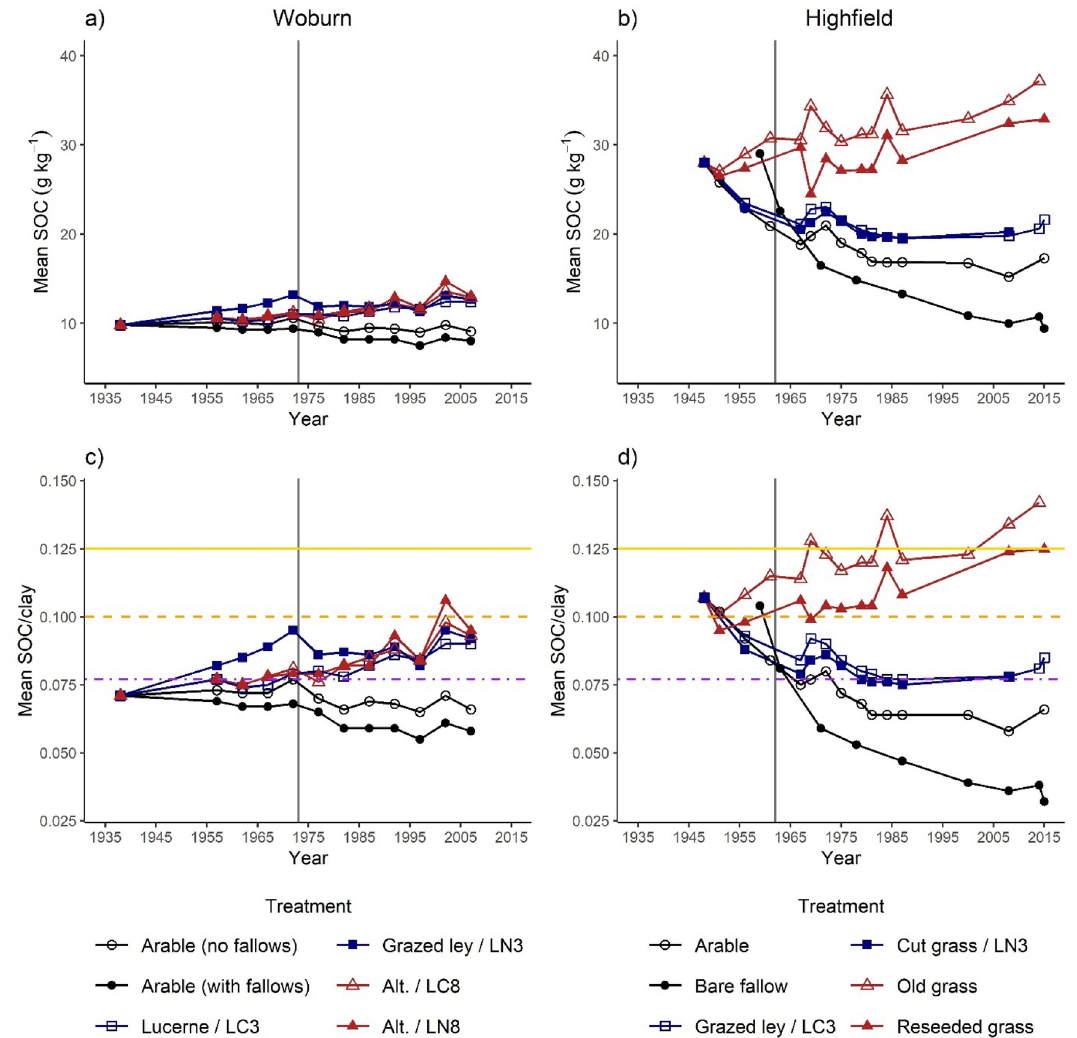
Figure 5. Mean SOC concentration and SOC/clay ratios over time in the long-term ley-arable rotation experiments at ( a , c ) Woburn (sandy loam) and ( b , d ) Highfield (silty clay loam). For standard deviations of each treatment at each timepoint see Supplementary Tables S1, S2, and S3. Horizontal lines represent SOC/clay index thresholds equal to 1/8 (solid), 1/10 (dashed), and 1/13 (dot-dash). The vertical line marks a change in treatments as indicated by the “/” in the legend entry. Alt. alternating treatment of 3-year arable, 3-year Lucerne, and 3-year grazed ley; LC3 3-year ley + clover; LN3 3-year ley + nitrogen; LC8 8-year ley + clover; LN8 8-year ley +